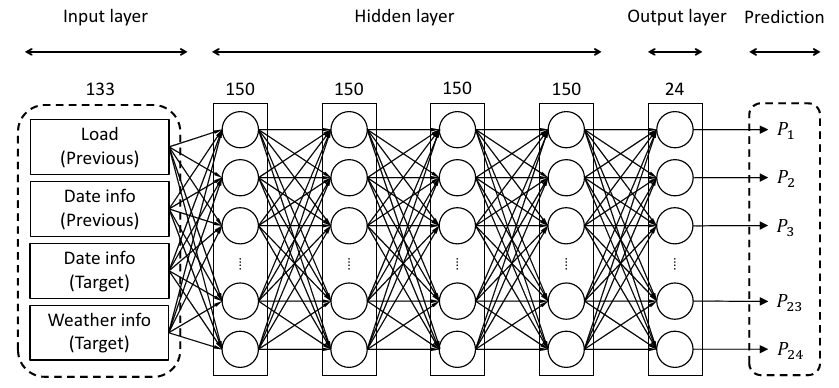
Figure 8. The structure of